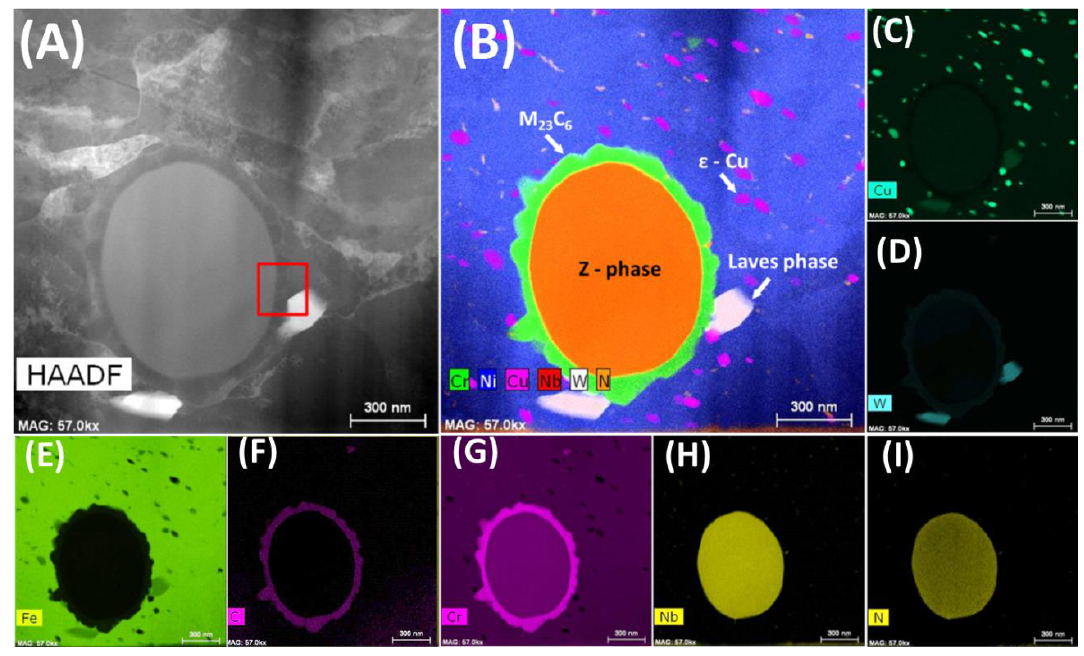
Figure 5. STEM data for the bulk material after 5000 h of oxidation at 700 °C: ( A ) HAADF image showing Z-phase, ( B ) – ( I ) EDS map of selected elements .